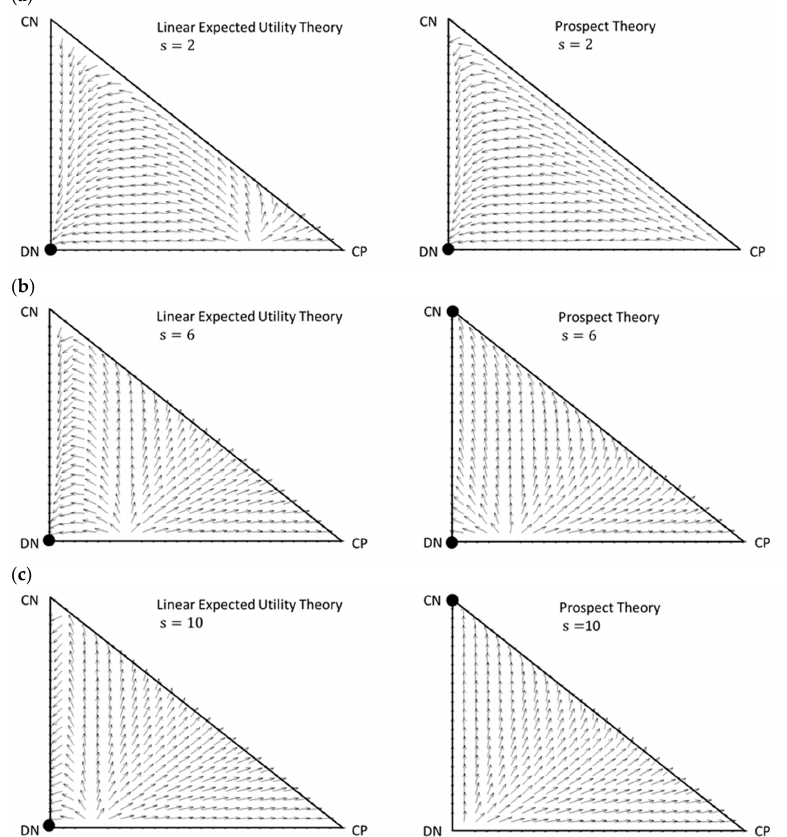
Figure 2. The vector fields yielded by the replicator dynamics for the linear expected utility theory (left panel) and for the prospect theory (right panel). The state space is the simplex defined by ≤ 1,0 ≤ x ≤ 1,0 ≤ x ≤ 1, x + x + x = 1 } , which is drawn as a rectangular ) | 0 ≤ x { ( x 2 2 1 , x 2 , x 4 1 4 1 4 triangle. The arrows in each triangle show in which direction the state ( x 1 , x 2 , x 4 ) evolves in the rectangular triangle (including its edges). Parameters: c = r = 1, b = 4, ε = 0.05. The strength of punishment is varied: ( a ) s = 1, ( b ) s = 6, ( c ) s = 10. Stable fixed points are illustrated as solid circles. We see that CN becomes stable as s becomes larger for prospect theory, while DN is the unique stable fixed point in all cases for the linear expected utility